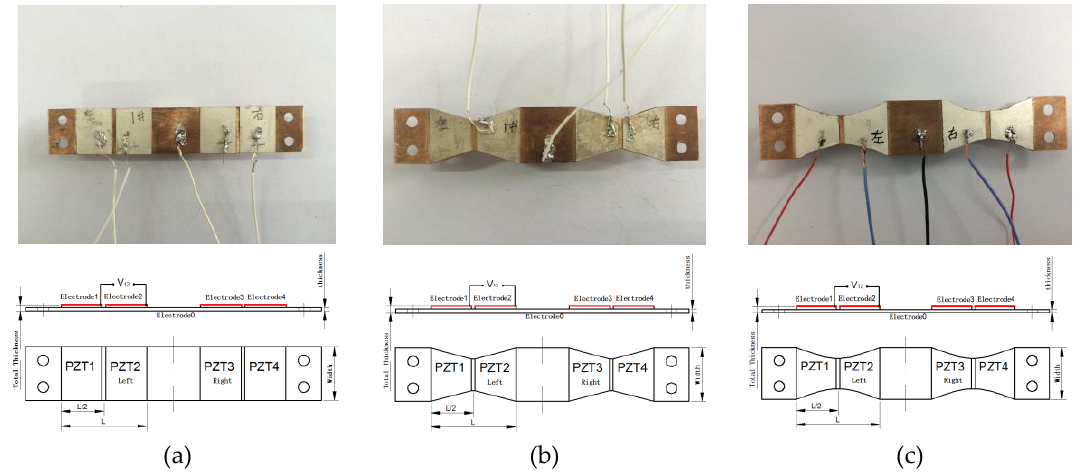
Figure 5. Three shape kinds of designed and manufactured double-clamped beam structures. ( a ) Rectangular, ( b ) Trapezoidal, ( c ) Concave parabolic.